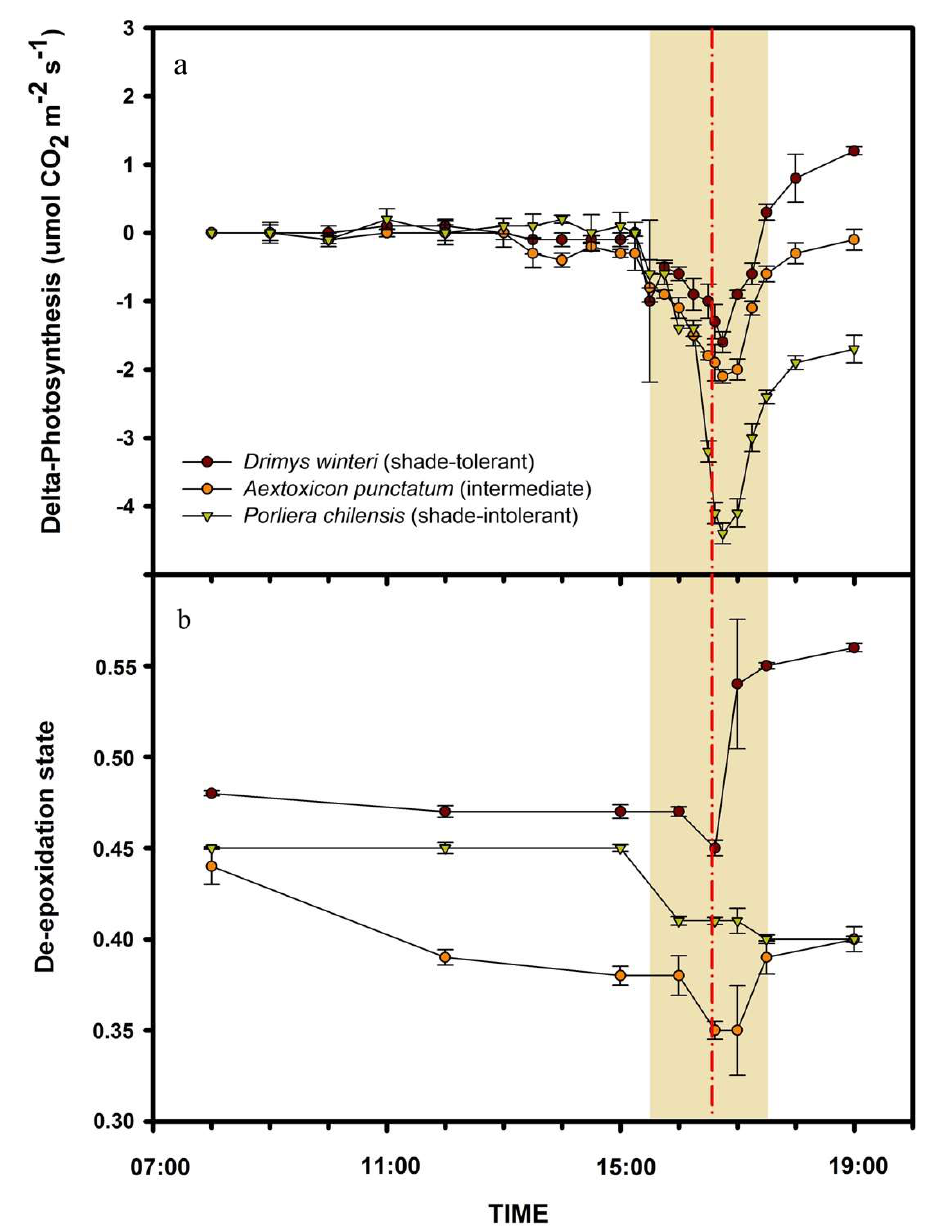
Figure 2. Daily photosynthesis differential (photosynthesis during an eclipse day—photosynthesis during a non-eclipse day) ( a ) and daily de-epoxidation state during an eclipse in Drimys winteri (shade-tolerant, red circles) ( b ), Aextoxicon punctatum (intermediate, orange circles), and Porlieria chilensis (shade-intolerant, yellow triangles). Shaded zones represent partial solar eclipse. The red dashed vertical line represents total solar eclipse (2 July 2019). Mean ± 1 SD are shown.